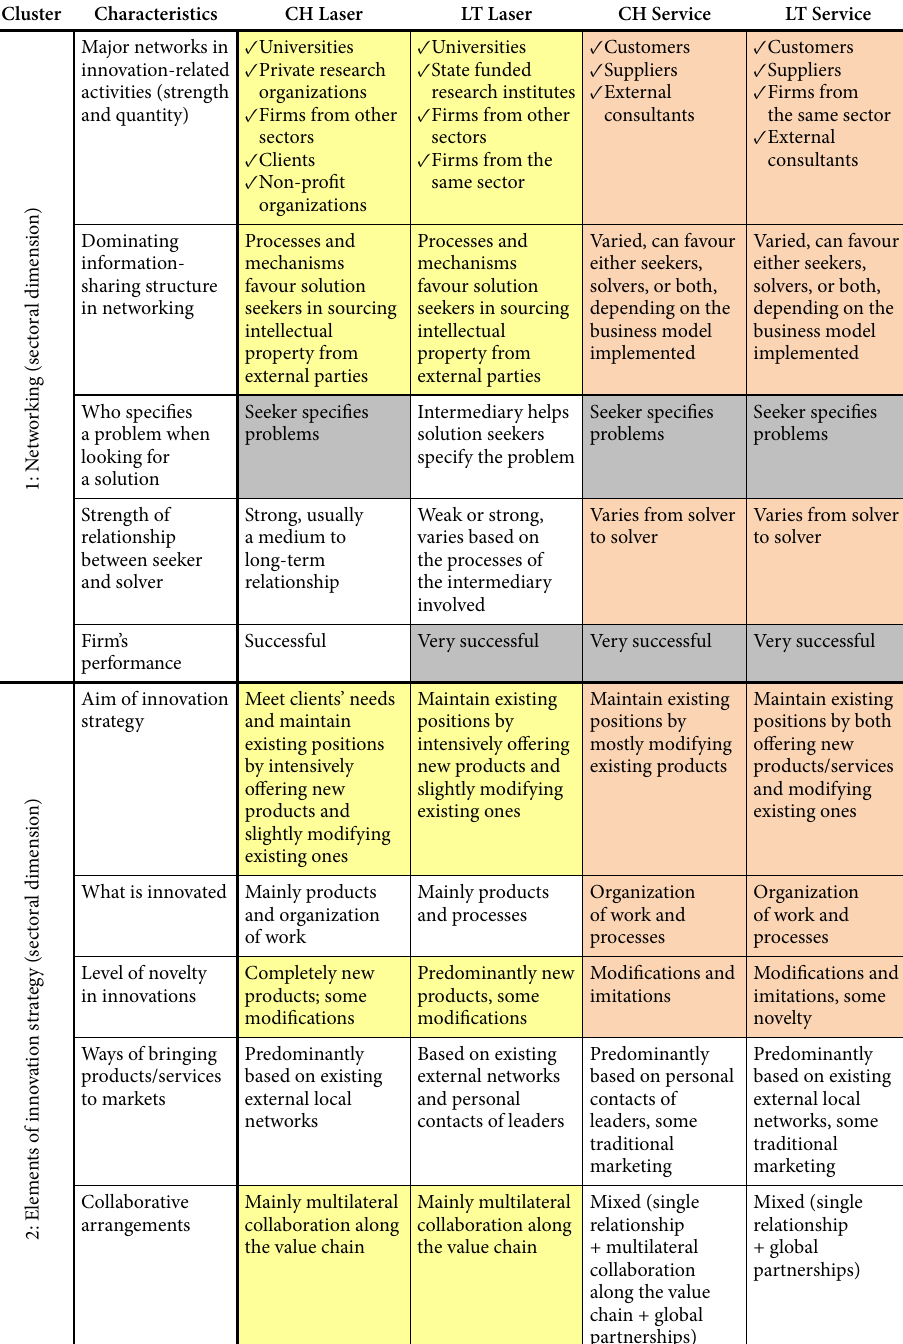
Table 5. The sample innovation strategies along their characteristics which make most of difference Cluster